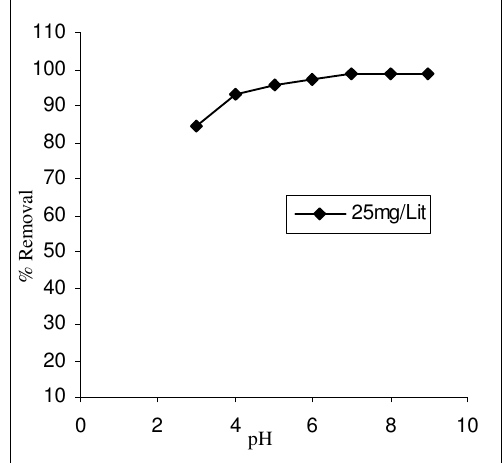
Figure 7. Effect of pH on Crystal violet adsorption.